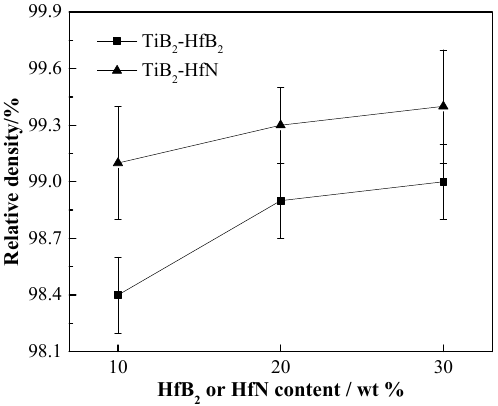
Figure 5. Relative densities of TiB 2 -HfB 2 and TiB 2 -HfN ceramic tool materials.